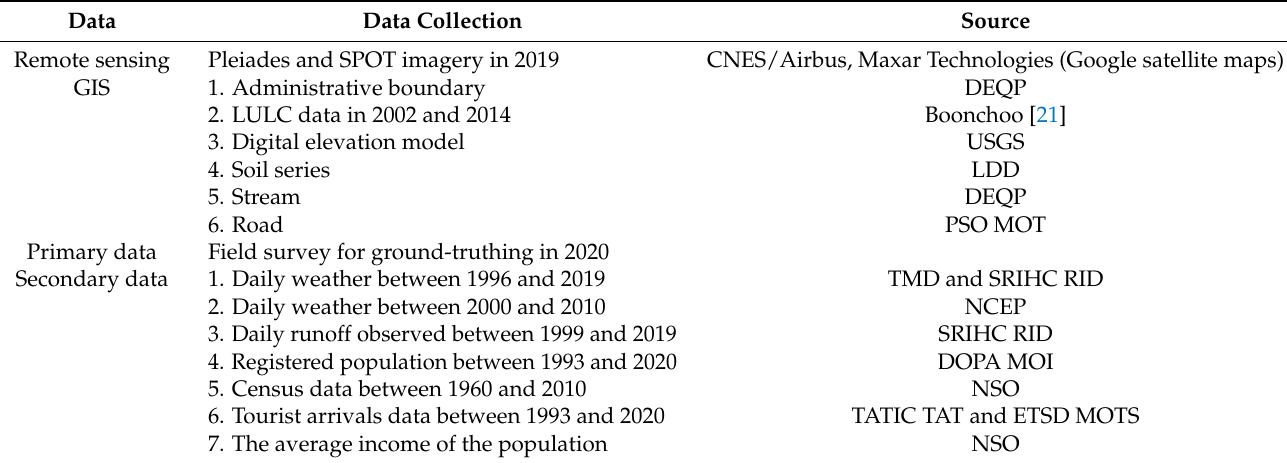
Figure 2. Workflow of research methodology. Table 1. Details of data collection and preparation for analysis and modeling in the study.